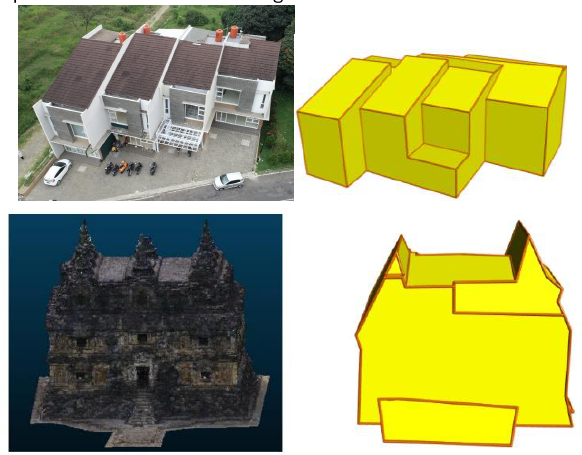
Figure 10. Final result of PolyFit Optimization in front look